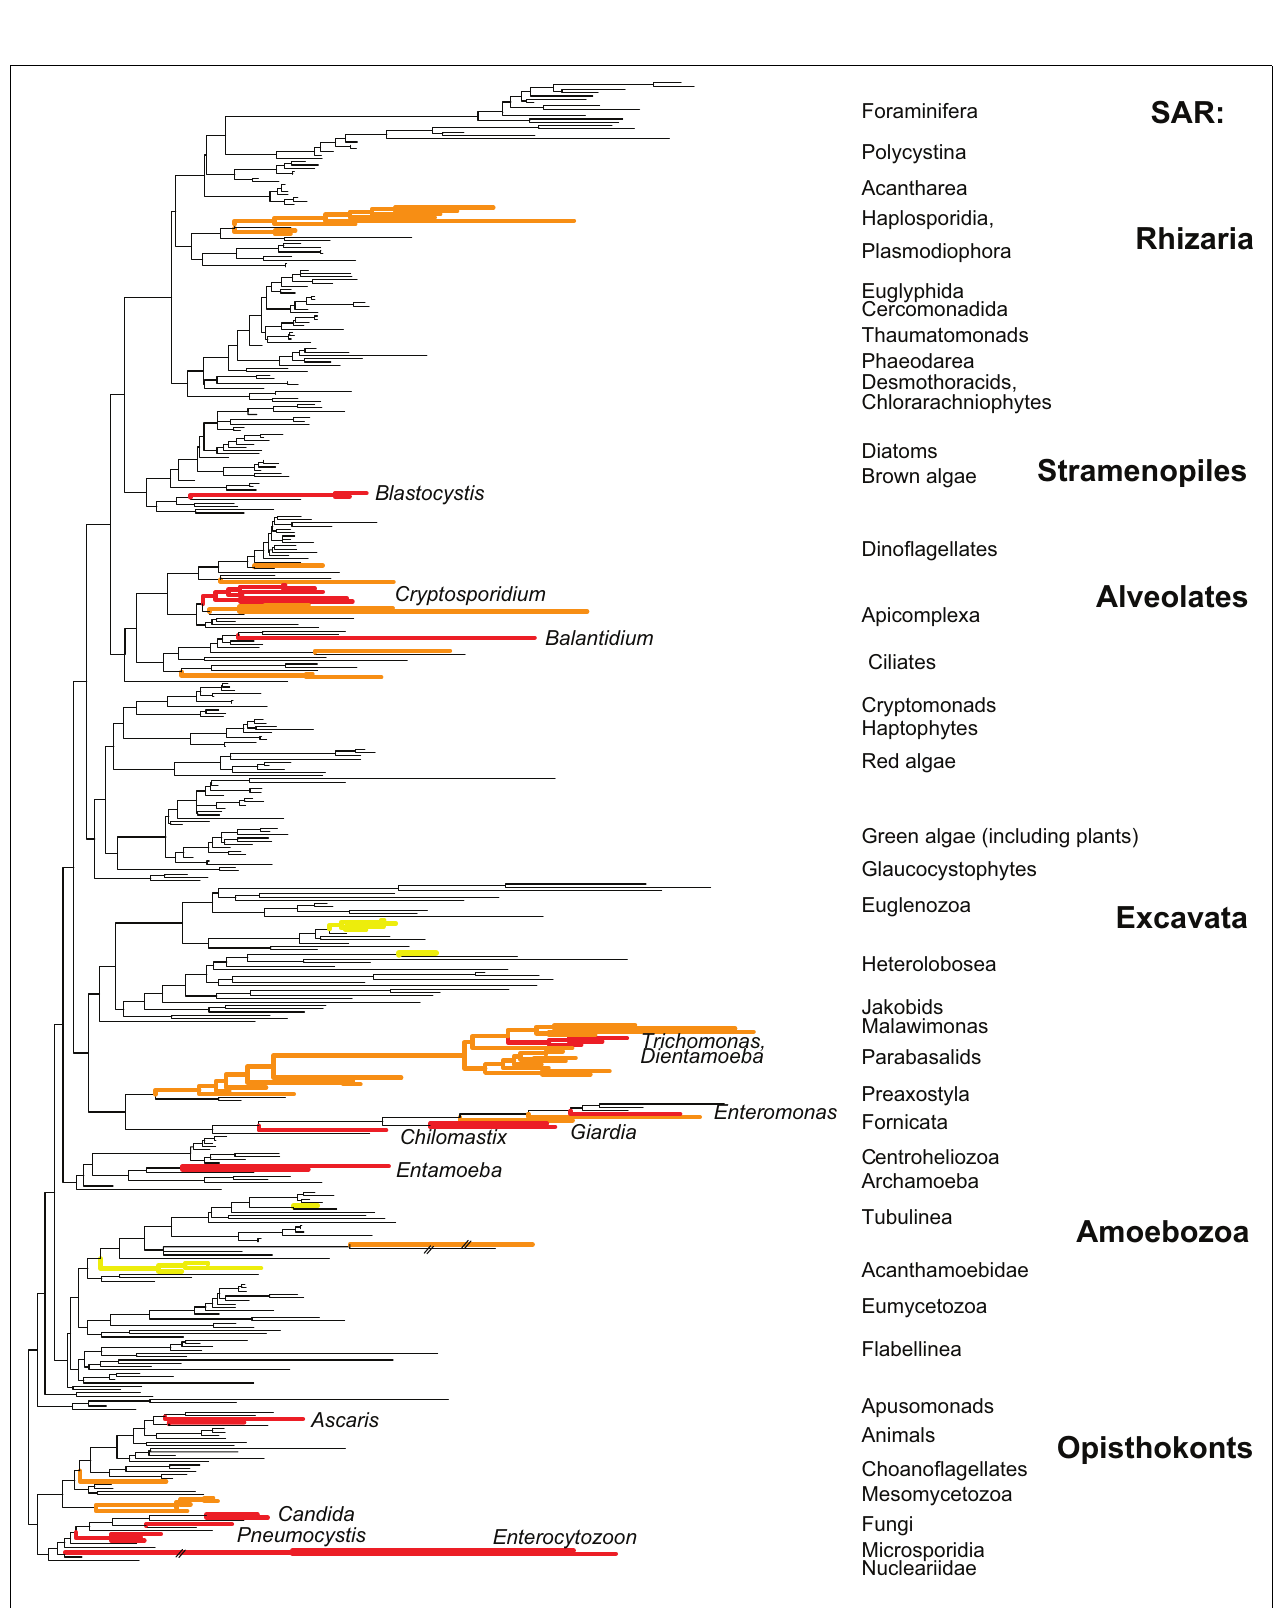
represent lineages found in invertebrates (some red lineages are also present in invertebrates).Yellow taxa are non-gut parasites of humans.Tree is based on Parfrey et al.